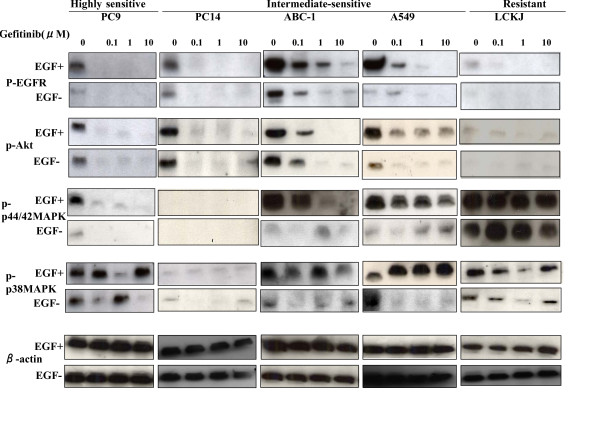
Lung cancer cell lines: Effect of gefitinib on phosphorylated EGFR(p-EGFR), phosphorylated Akt (p-Akt) and the molecules in the Ras/MEK/Erk pathway with or without EGF.